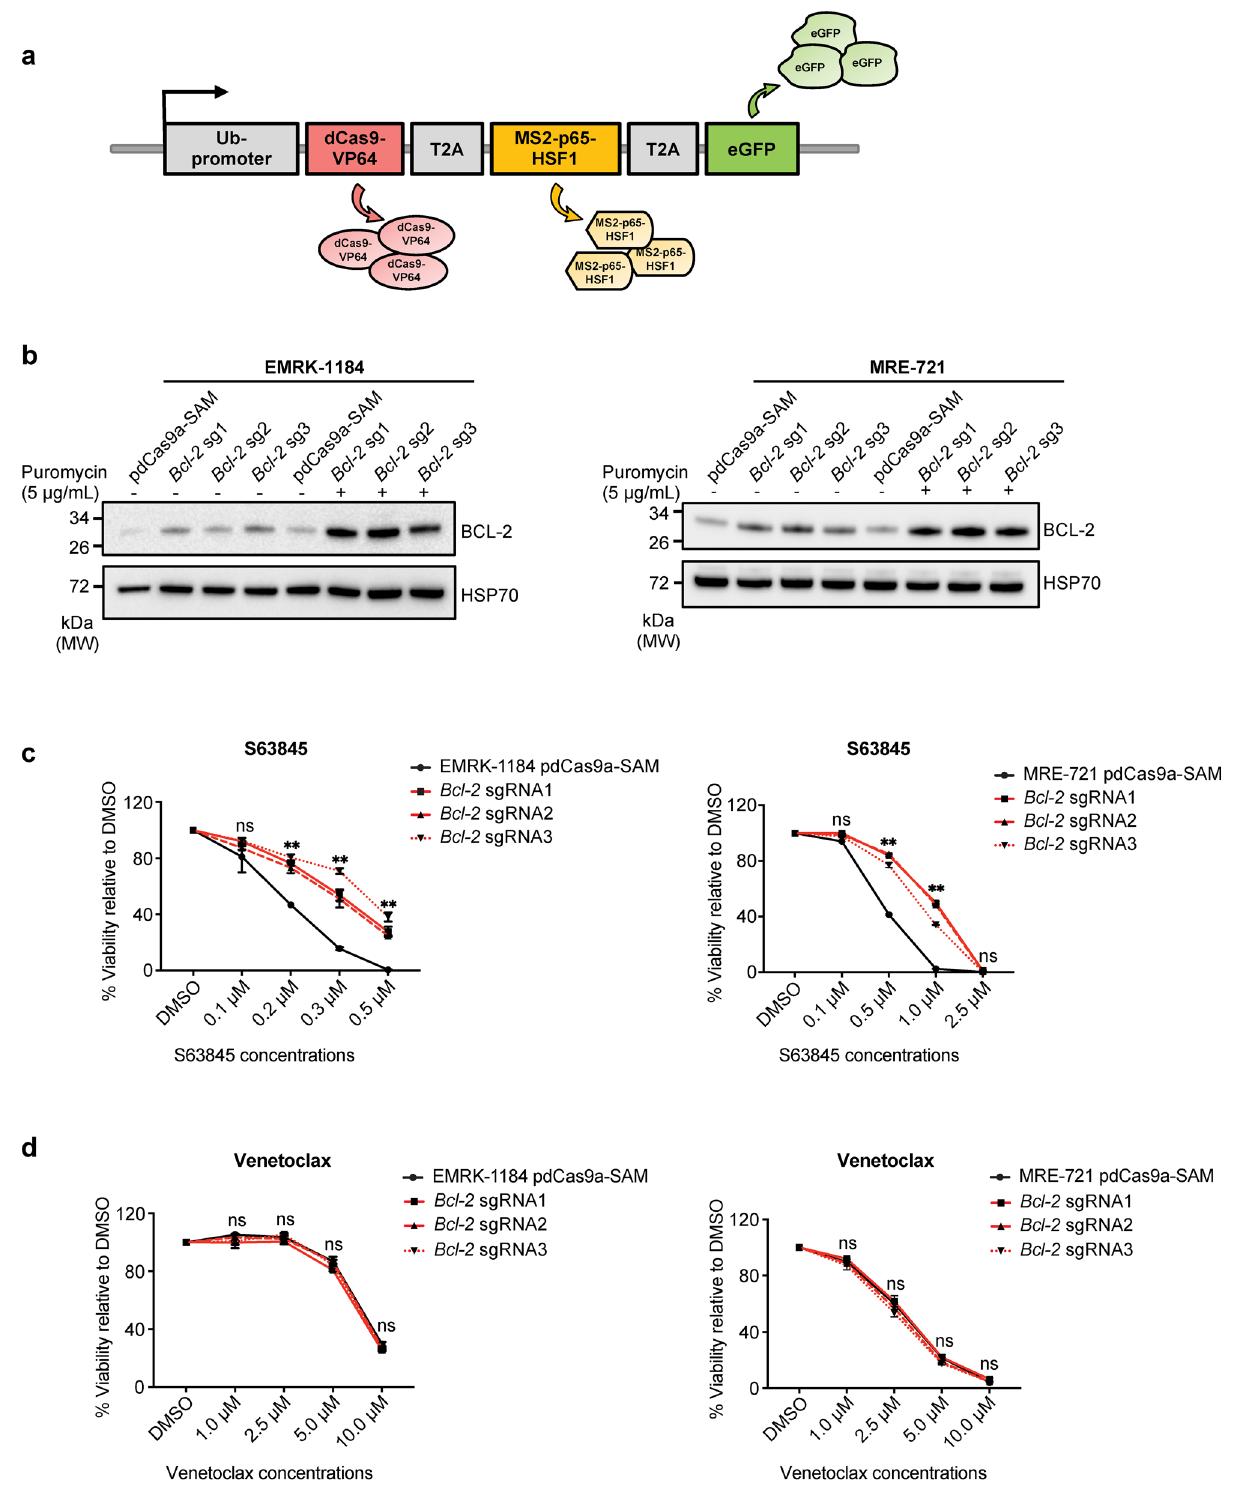
Fig. 1 | Generation and validation of pdCas9a-SAM construct in E µ -Myc lym- phoma cell lines. a Schematic representation of the pdCas9a-SAM lentiviral con- struct. b Western blot analysis for BCL-2 in manipulated E µ -Myc lymphoma cell lines. EMRK-1184 or MRE-721 E µ -Myc lymphoma-derived cell lines were transduced with pdCas9a-SAM only or pdCas9a-SAM plus Bcl-2 sgRNAs. Cell lysates were har- vested from transduced cell lines, before or after puromycin-selection and expressionoftheindicatedproteinswasexaminedbyWesternblotting.Probingfor the heat shock protein 70 (HSP70) served as a loading control. 2 independent experiments were performed showing similar results. c , d Viability of E µ -Myc